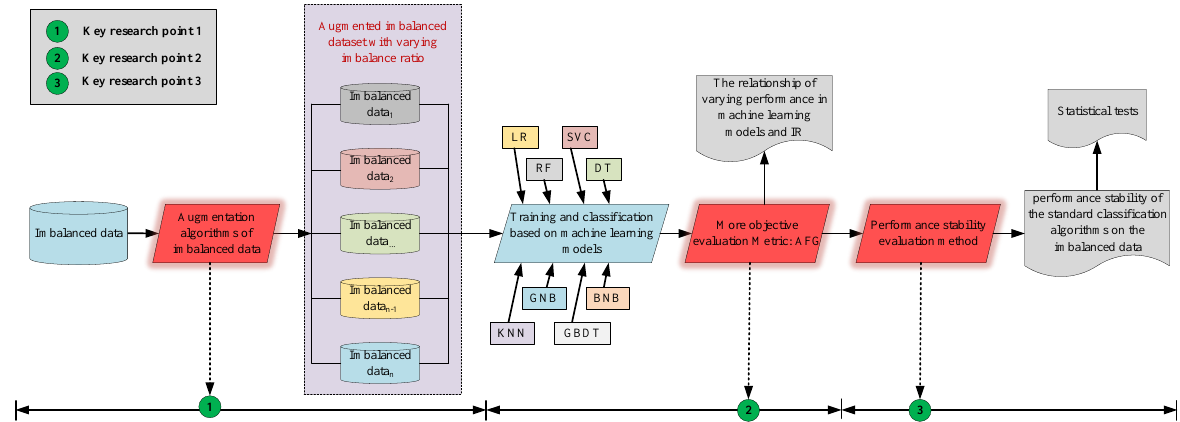
Figure 1. Overall framework of the proposed method.